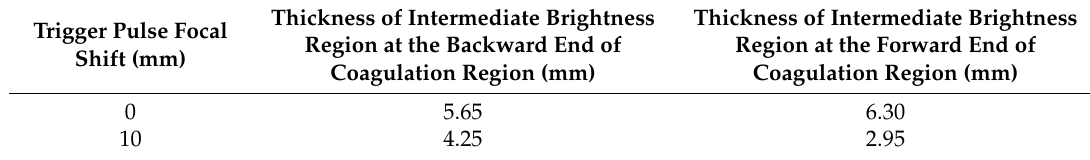
Figure 12. Cross-sectional pictures of the coagulated chicken breast tissues. ( a ) the focal plane of the trigger pulses was not shifted; ( b ) the focal plane of the trigger pulses was shifted 10 mm forward from that of the heating bursts. Table 2. Thickness of intermediate brightness regions at the ends of a coagulation region in a chicken breast tissue without and with the focal plane shift of trigger pulses [34].